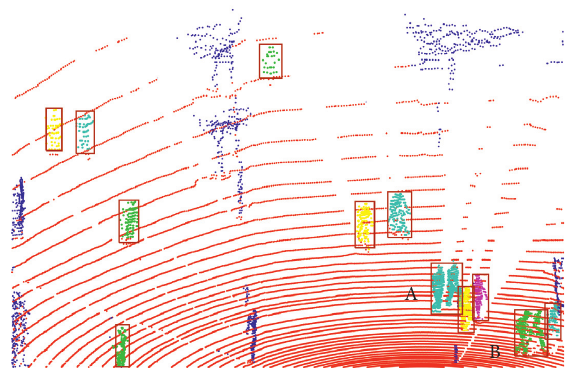
Figure 1: Segmentation of moving object point cloud at one